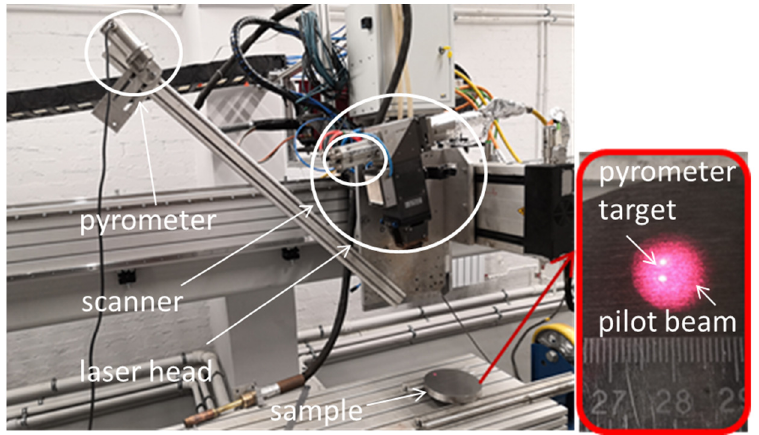
Figure 1. The location of the optical instruments during the heat treatment of the sample. The laser head YW50 ZK had a DC-ILV scanner with mode parameters of scanning in the transverse hardening direction: frequency 50–800 Hz, amplitude 2.0–12.0